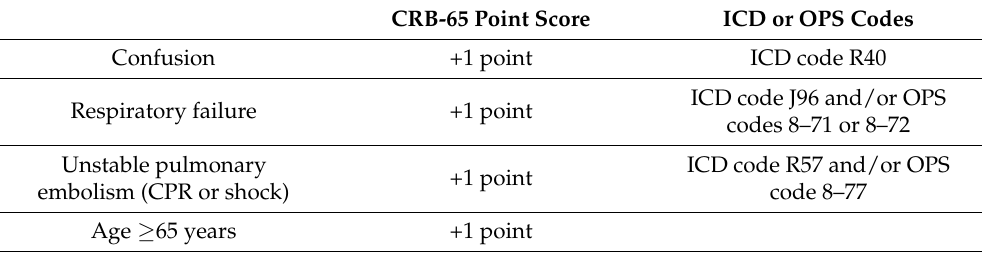
Table 1. Items of the CRB-65 score and analysed